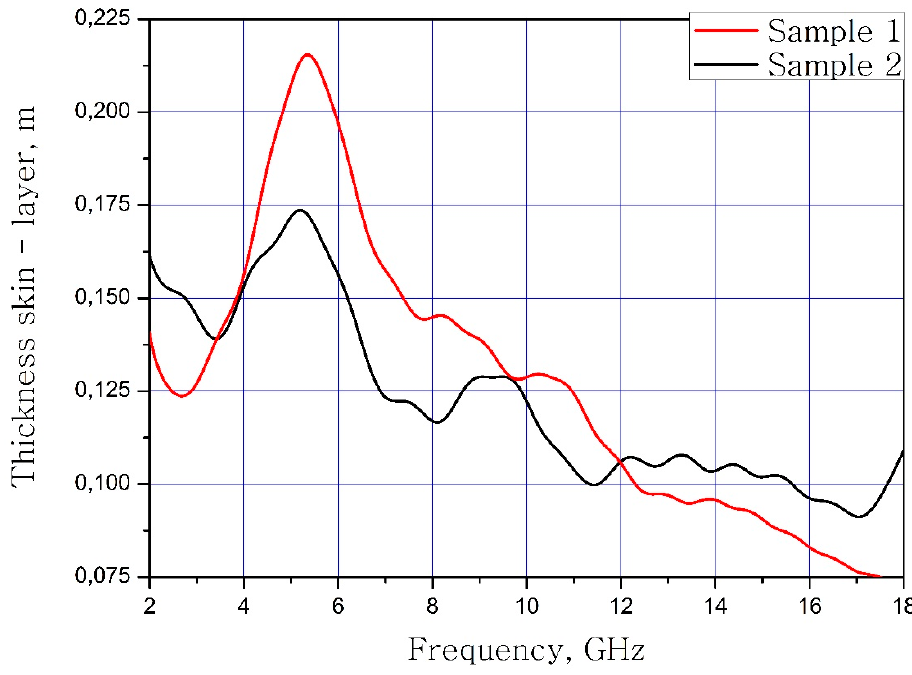
Figure 9. The frequency dependence of the thickness of the skin layer of samples.